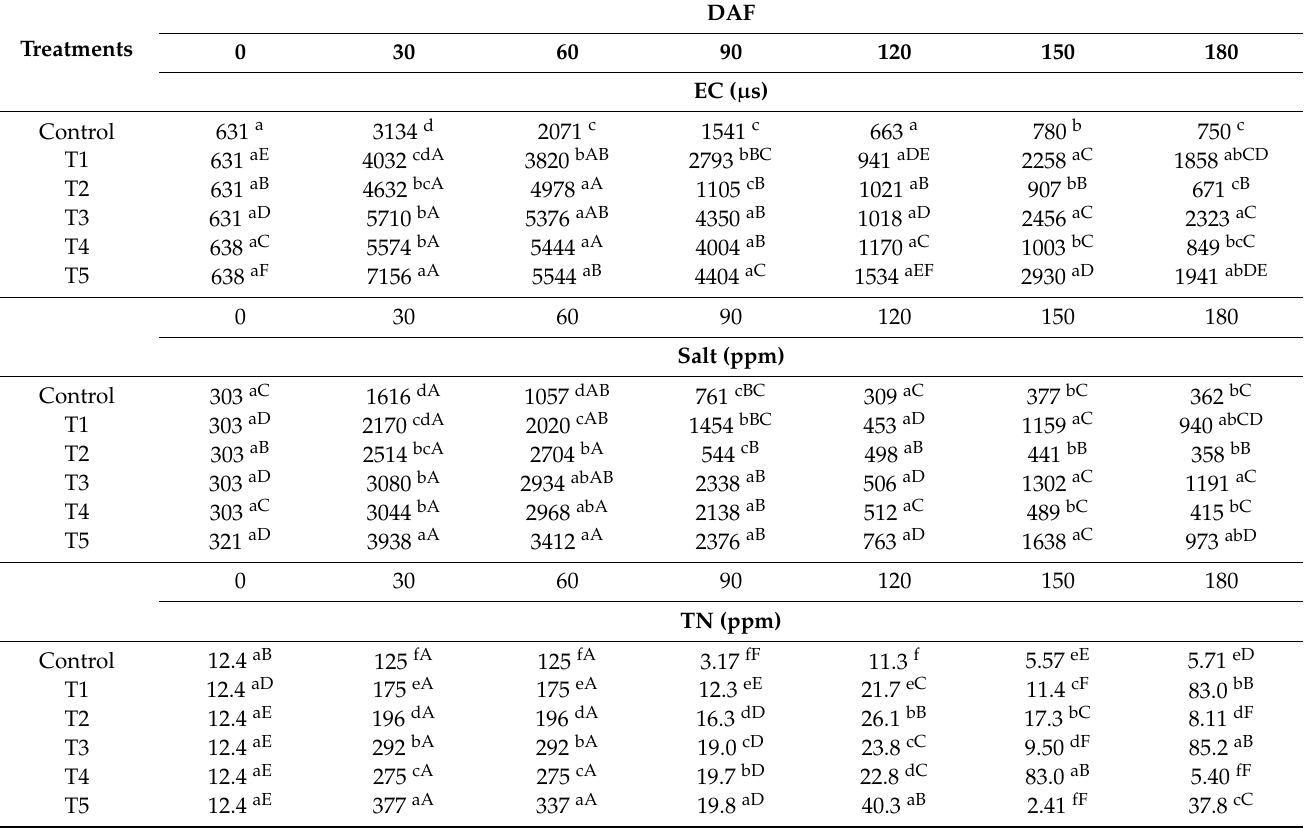
Table 6. Electric conductivity (EC), salt, and total nitrogen (TN) of the leachate samples of cocoa plants under different fertilization rates from 0 to 6